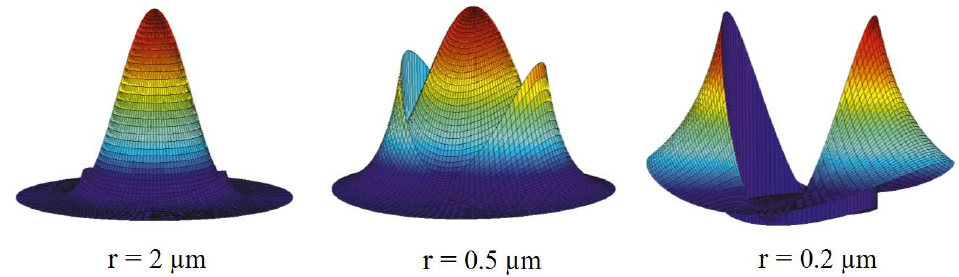
Figure 8. Field intensity distribution of silica MFs in air with radii of ( a ) 1 μm, ( b ) 0.5 μm and ( c ) 0.2 μm. The MF capability to confine light in small waist regions, together with an extremely small end-face cross section, have attracted extreme interest for bio-detection, intracellular sensing and plasmonic environment detectors as shown in Figure 9 [25].